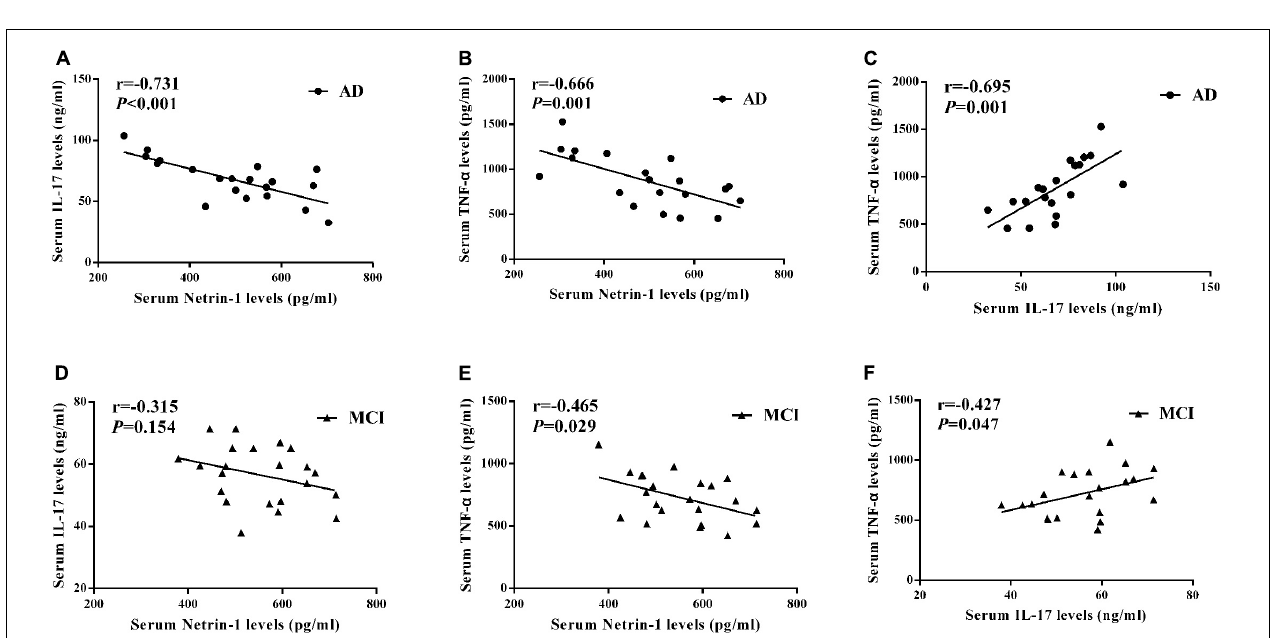
FIGURE 4 | Correlations among serum (A) netrin-1 and IL-17 in AD patients, (B) netrin-1 and TNF- α in AD patients, (C) IL-17 and TNF- α in AD patients, (D) netrin-1 and IL-17 in MCI patients, (E) netrin-1 and TNF- α in MCI patients, and (F) IL-17 and TNF- α in MCI patients.